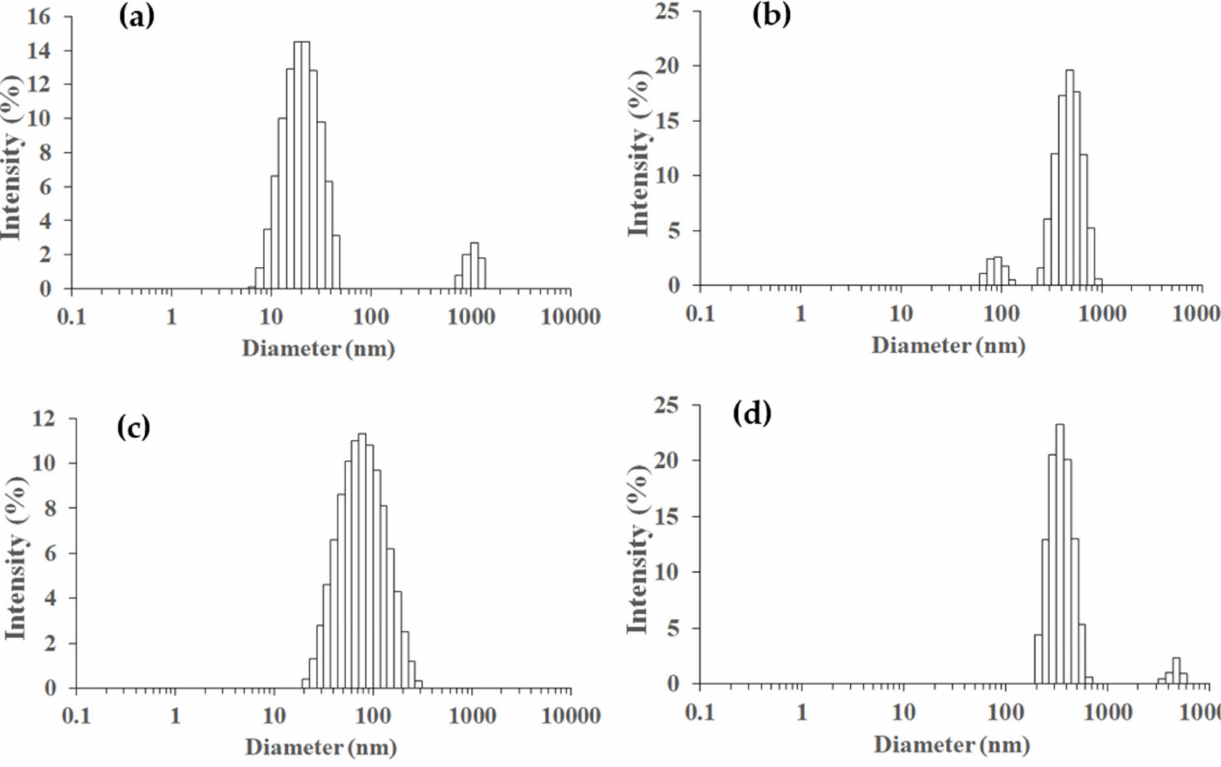
Figure 19. Particle size distributions measured on a Zetasizer Nano ZS of TiO 2 and Ti x Si y oxide synthesized at pH 9.0 with different Ti/Si ratios: ( a ) TiO 2 , ( b ) Ti 70 Si 30 , ( c ) Ti 50 Si 50 , ( d ) Ti 40 Si 60